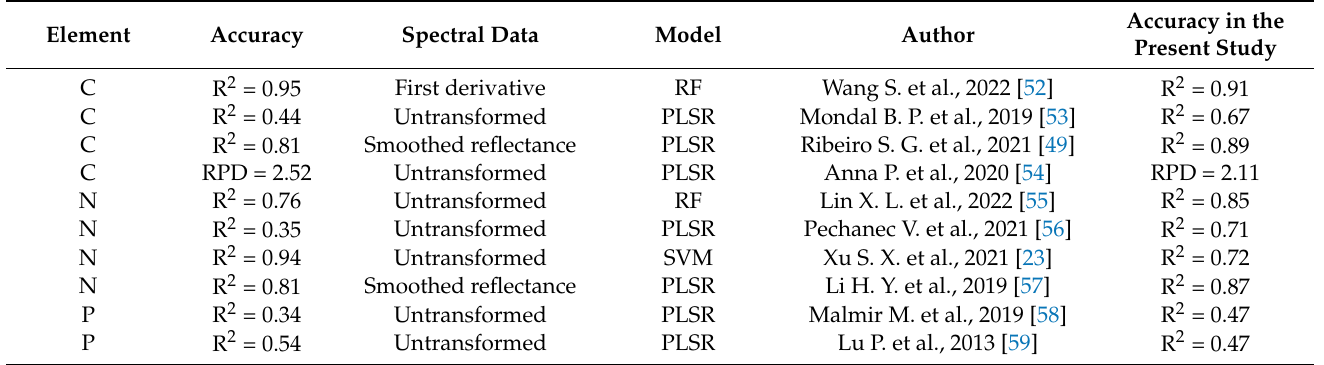
Table 2. Comparison of soil carbon, nitrogen, and phosphorus between other research results and this